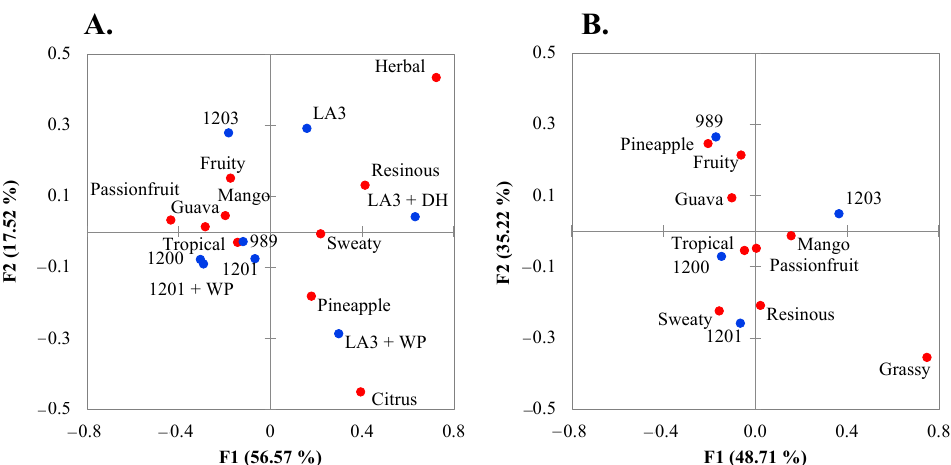
Figure 2. Correspondence analysis of sensory CATA data for all yeast strains ( A ) and genetically modified strains excluding parent strain and varied hopping treatments ( B ).